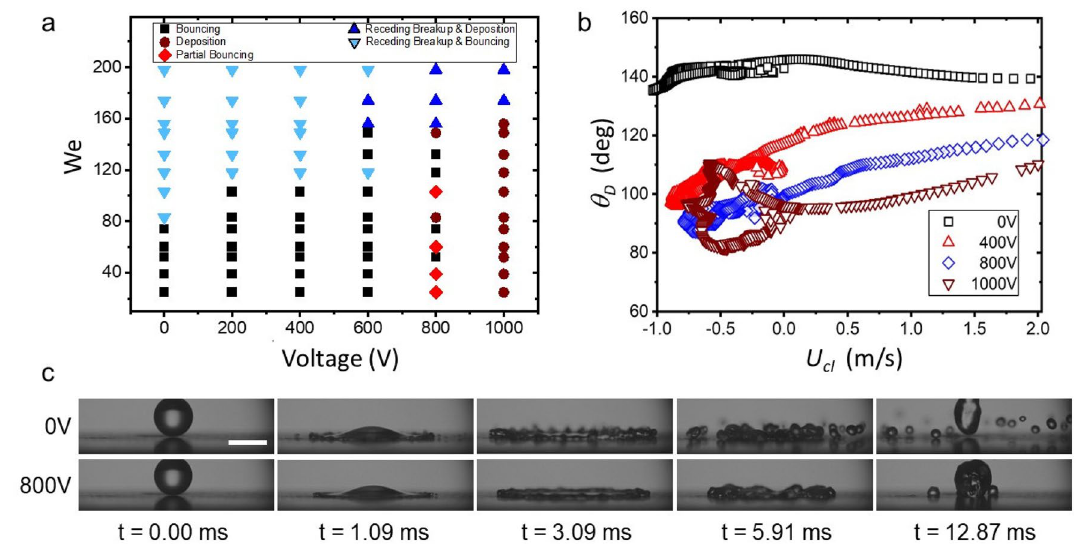
Figure 2. ( a ) Bouncing/no-bouncing map behaviour in terms of the Weber number and the applied AC voltage. ( b ) Dynamic contact angle in terms of the contact line velocity for different applied dielectrowetting voltages at We = 52. ( c ) Snapshots of a water droplet impacting at We = 74; at V = 0 V receding breakup and bouncing is observed but receding breakup and deposition is observed at V = 800 V (the droplet remains on the substrate). Scale size = 2.5